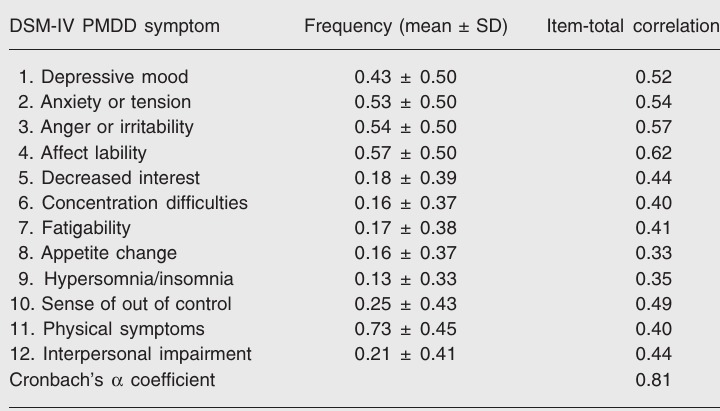
Data are reported as means ± SD. *Corrected item-total correlation. PMDD = premen- strual dysphoric disorder.